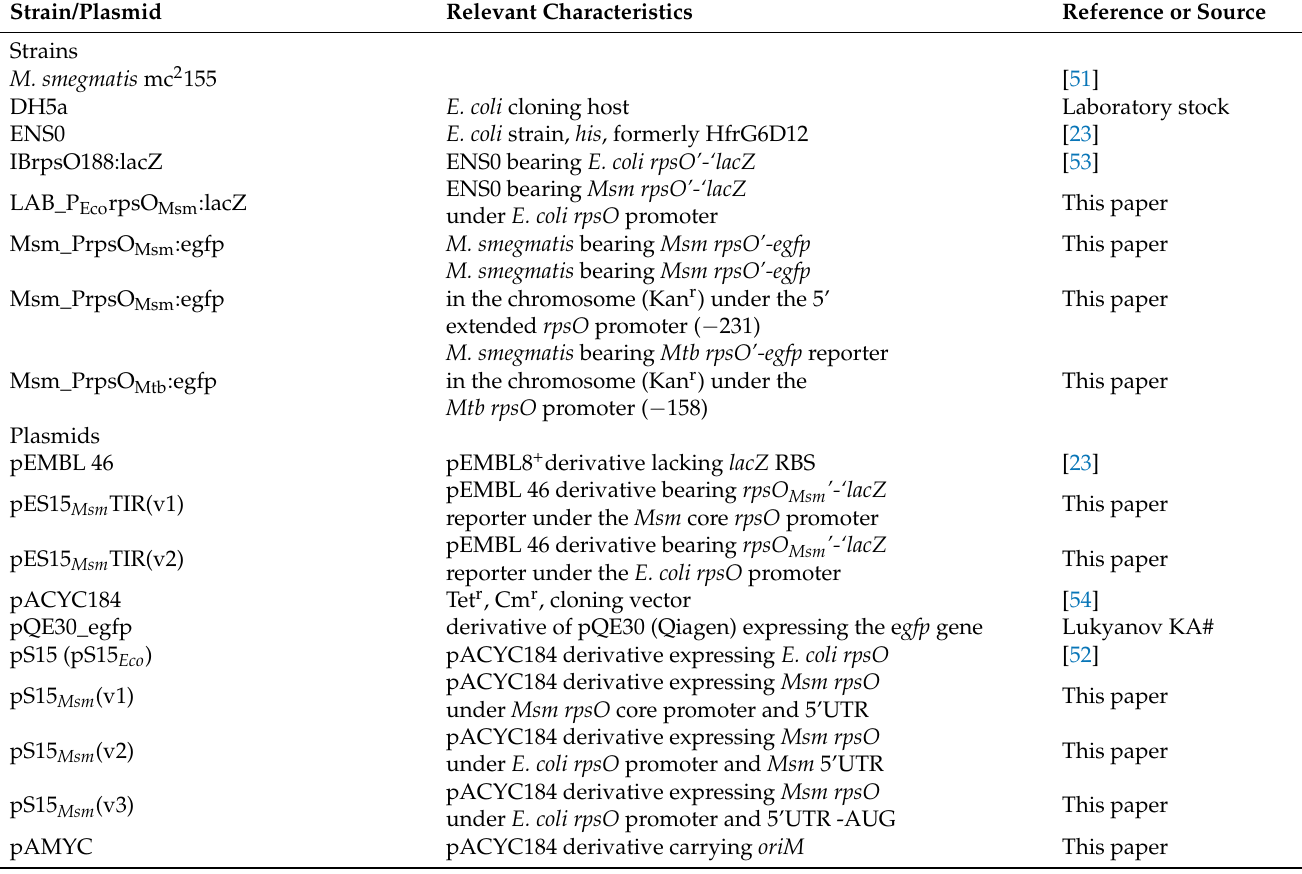
Table 1. Strains and plasmids used in this